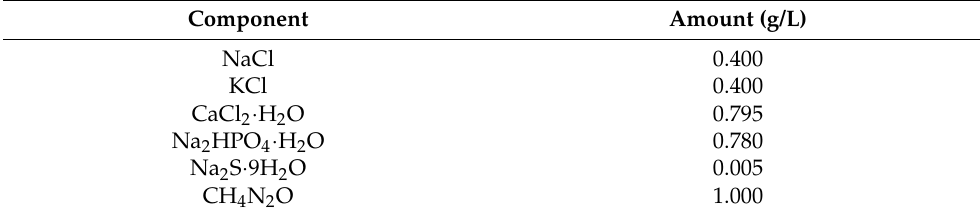
Table 3. Composition of the artificial saliva.